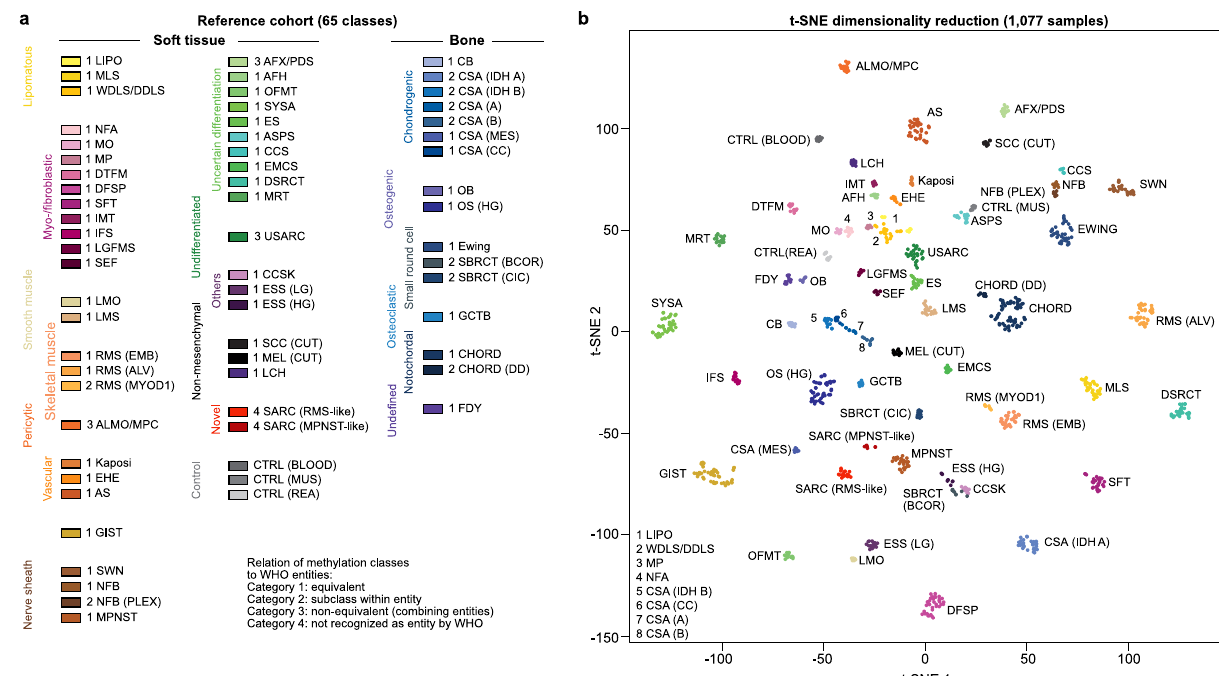
Fig. 1 Establishing the DNA methylation-based sarcoma reference cohort. a Overview of 62 tumour and three control DNA methylation classes included in the sarcoma classi fi er reference cohort. The methylation classes are colour-coded and grouped according to the WHO scheme. The relation between methylation classes and the WHO de fi ned subtypes is categorised in 4 tiers: equivalent to a WHO entity (category 1); subgroup of a WHO entity (category 2); combining WHO entities (category 3); non-de fi ned by WHO (category 4). b Visualisation of the reference cohort methylation pro fi les ( n = 1,077) using t-distributed stochastic neighbour embedding (t-SNE) dimensionality reduction. Individual samples are colour-coded in the respective class colour ( n = 65) as given in ( a ). Abbreviations: LIPO, lipoma; MLS, myxoid liposarcoma; WDLS/DDLS, well differentiated liposarcoma/dedifferentiated liposarcoma; NFA, nodular fasciitis; MO, myositis ossi fi cans; MP, myositis proliferans; DTFM, desmoid-type fi bromatosis; DFSP, dermato fi brosarcoma protuberans; SFT, solitary fi brous tumour; IMT, in fl ammatory myo fi broblastic tumour; IFS, infantile fi brosarcoma; LGFMS, low-grade fi bromyxoid sarcoma; SEF, sclerosing epithelioid fi brosarcoma; LMO, leiomyoma; LMS, leiomyosarcoma; RMS (EMB), embryonal rhabdomyosarcoma; RMS (ALV), alveolar rhabdomyosarcoma; RMS (MYOD1); rhabdomyosarcoma with MYOD1 mutation; ALMO/MPC, angioleiomyoma/myopericytoma; EHE, epithelioid haemangioendothelioma;